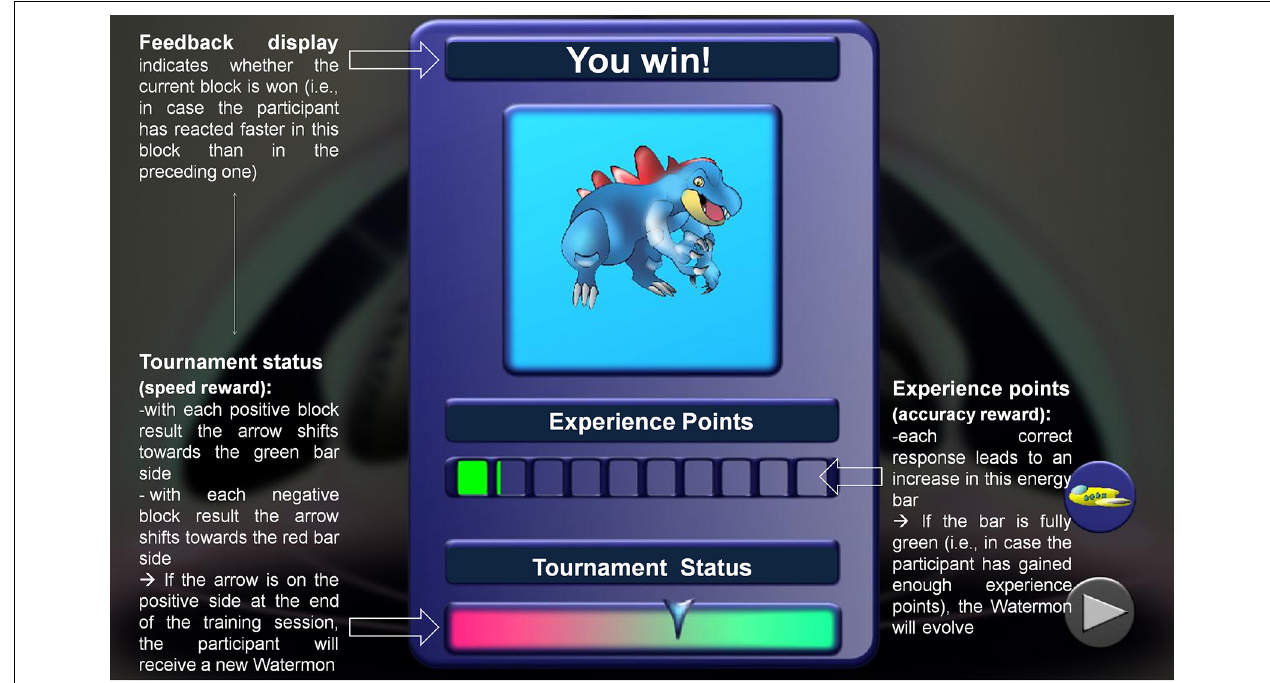
FIGURE 3 | Feedback display in the high-motivational